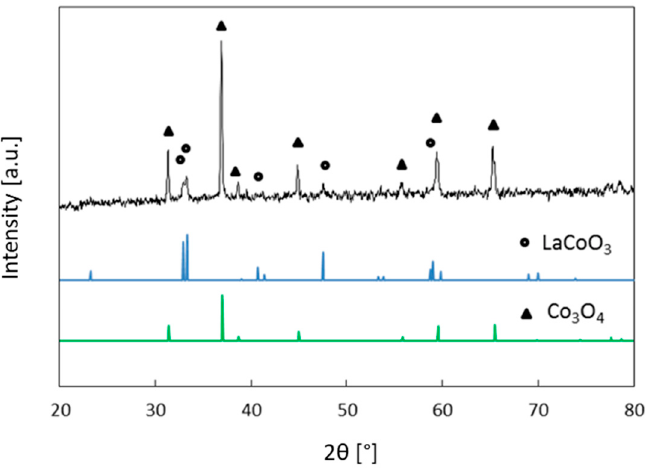
Figure 2. The X-ray diffraction (XRD) pattern of Co3.5La before experiments along with the appro- priate reference patterns of LaCoO 3 (48-0123)—circles and Co 3 O 4 (71-0816)—triangles.